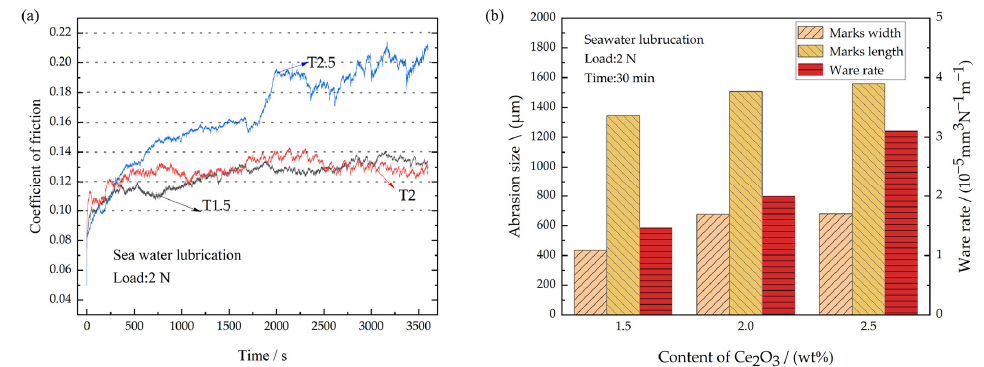
Figure 10. Friction coefficient and wear amount under seawater corrosion. ( a ) Coefficient of friction; ( b ) Wear amount.